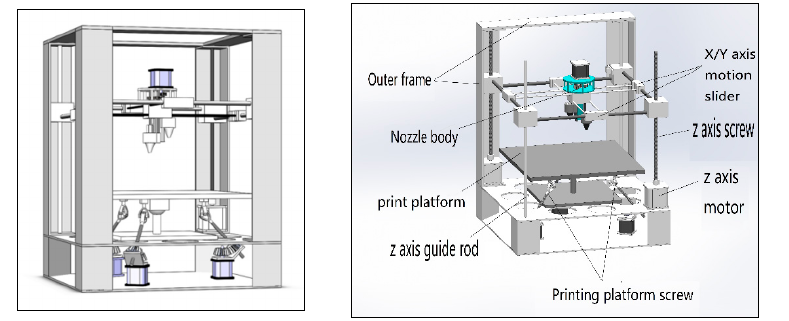
Figure 4. The 5-DOF hybrid three-nozzle 3D printer.